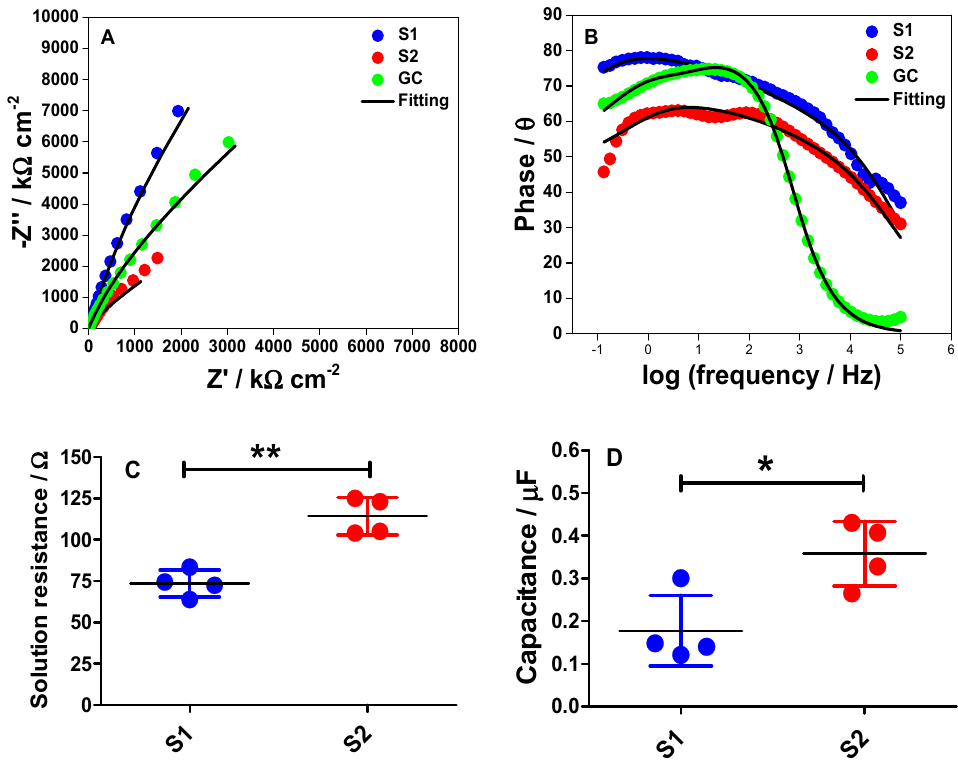
Figure 8. Nyquist ( A ) and Bode ( B ) plots for the GC, S1, and S2 electrodes at − 0.6 V vs. SCE in phosphate buffer solution (pH 7). Experimental data are depicted in filled circles whereas the solid lines are fitting to the equivalent circuit model as proposed in Figure S3. The measurements were made at a range of frequency from 100 kHz to 0.1 Hz and the modulation amplitude of 5 mV. ( C ) Comparison of the solution resistance ( R S ) for the S1 and S2 electrodes, determined from the EIS fittings. ( D ) Comparison of the obtained C dl values between the S1 and S2 electrodes from the EIS fittings. Statistical analyses were performed using an unpaired student t -test. Data shown as mean ± S.D., n = 4, * denotes p < 0.05 and ** denotes p < 0.01.